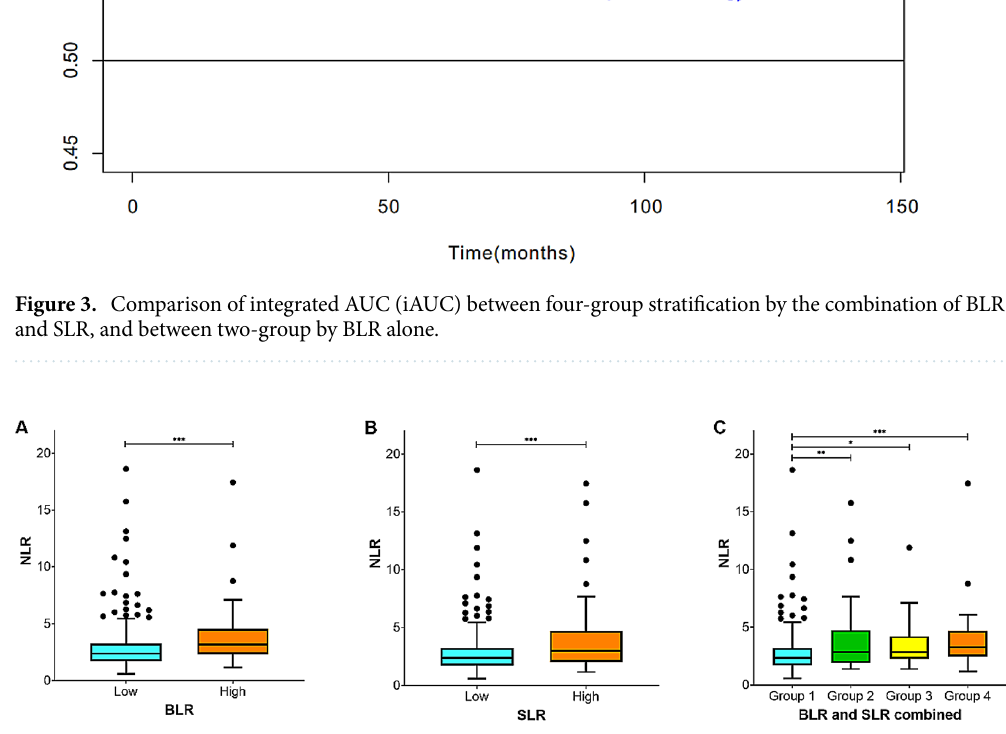
Figure 4. Distribution of NLR according to subgroups stratified by BLR (A), SLR (B), and combination of BLR and SLR (C). * p < 0.05; ** p < 0.01; *** p <